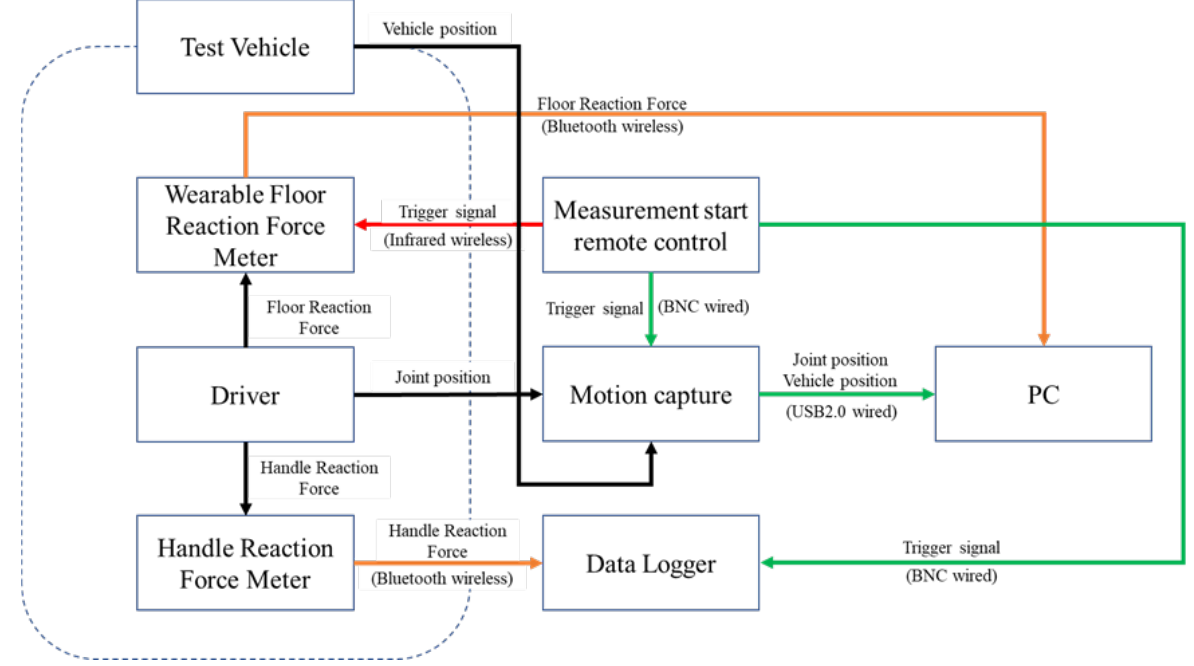
Figure 12. Flow diagram of the experimental setup.